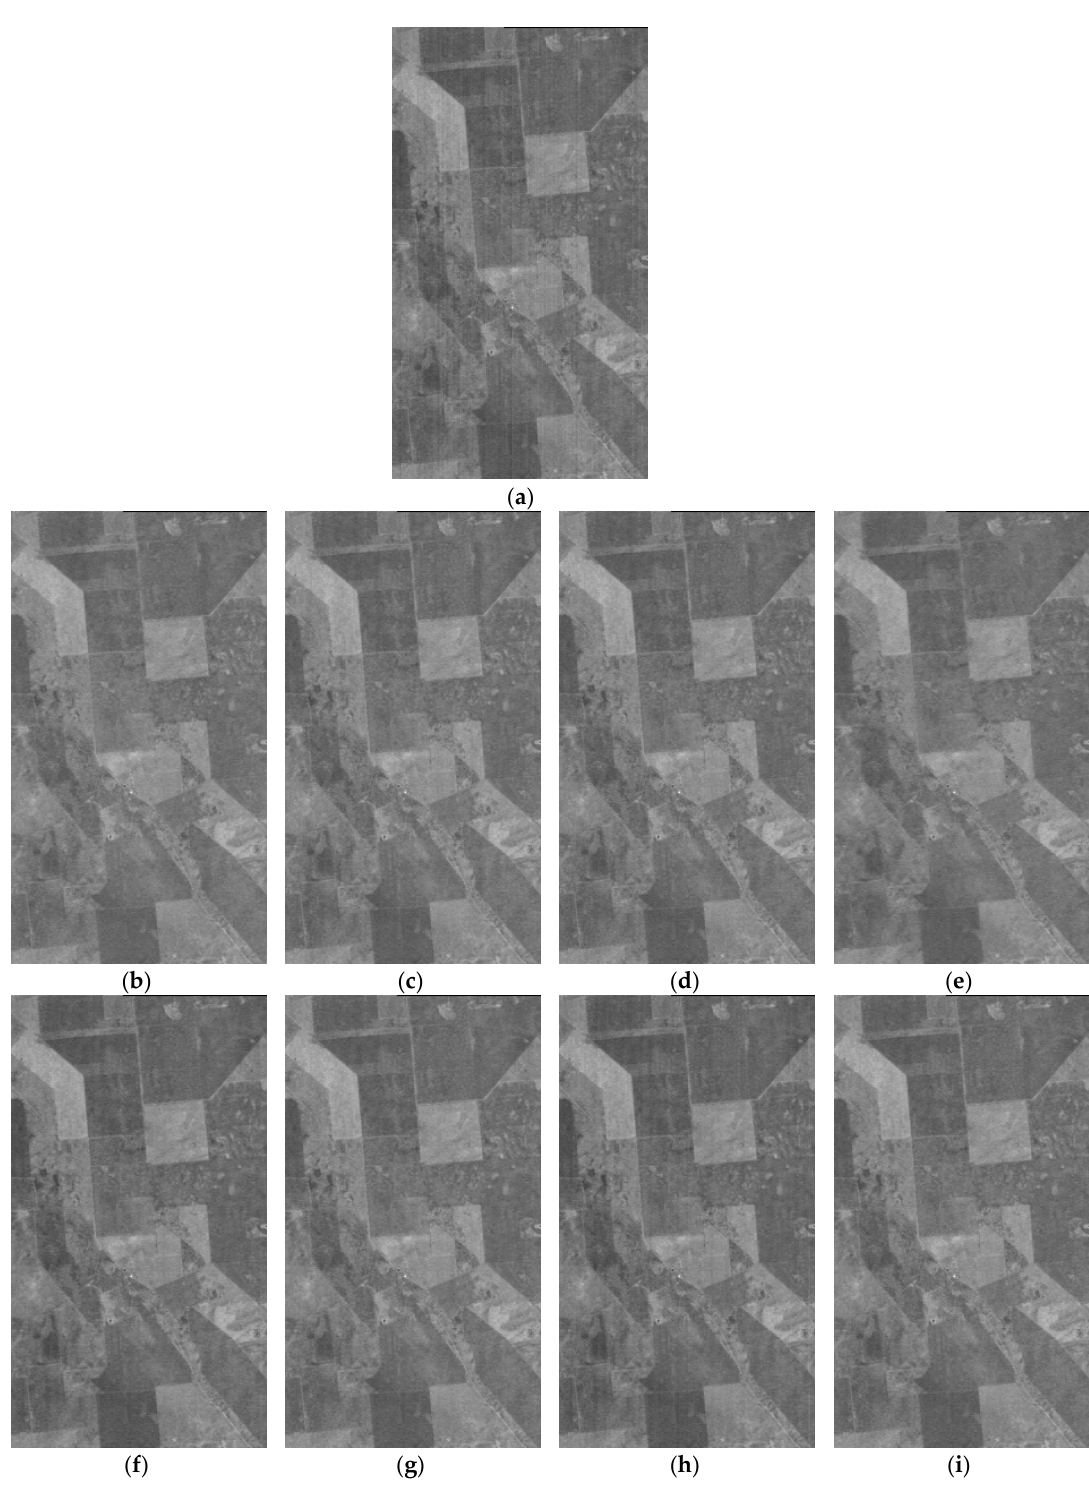
Figure 10. Destriping results of the second real data. ( a ) Original; and destriping results by ( b )